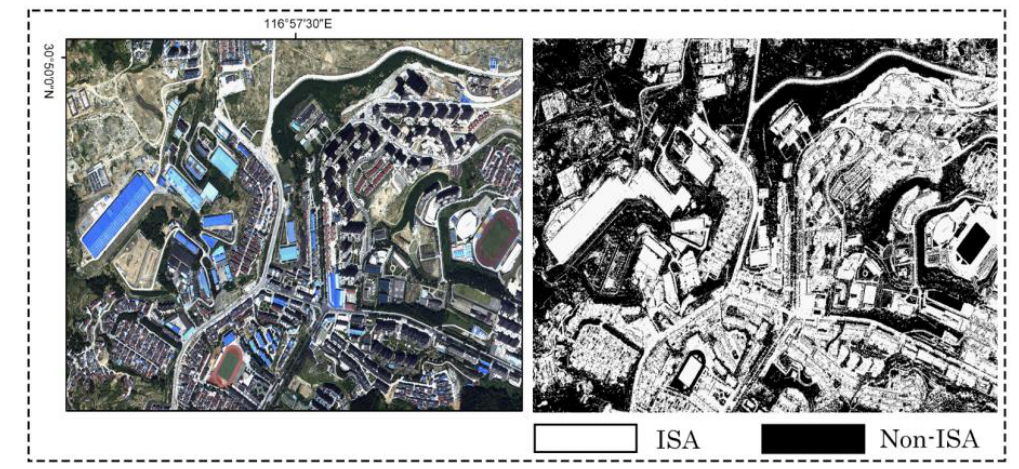
Figure 16. Worldview-3 image and its segmentation result by using PISI.